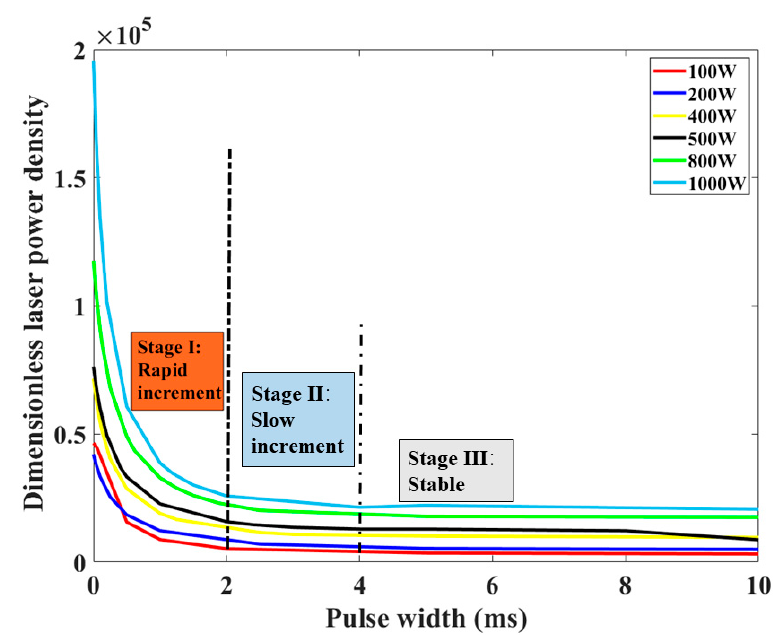
Figure 13. Variation of dimensionless laser power density with pulse width under different peak power.